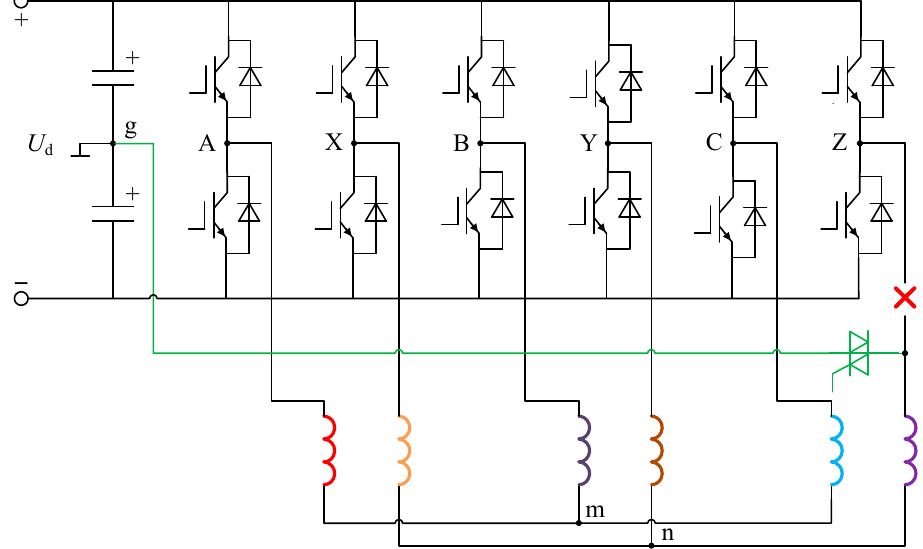
Figure 1. Post-fault circuit topology of windings and inverter.